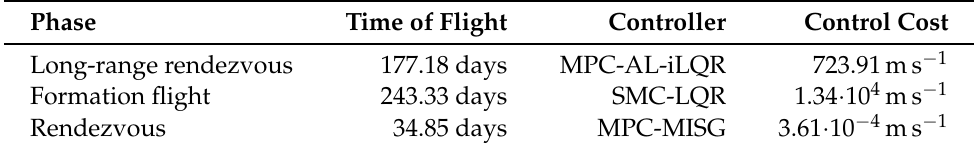
Table 7. Phase metrics for the JWST servicing mission.